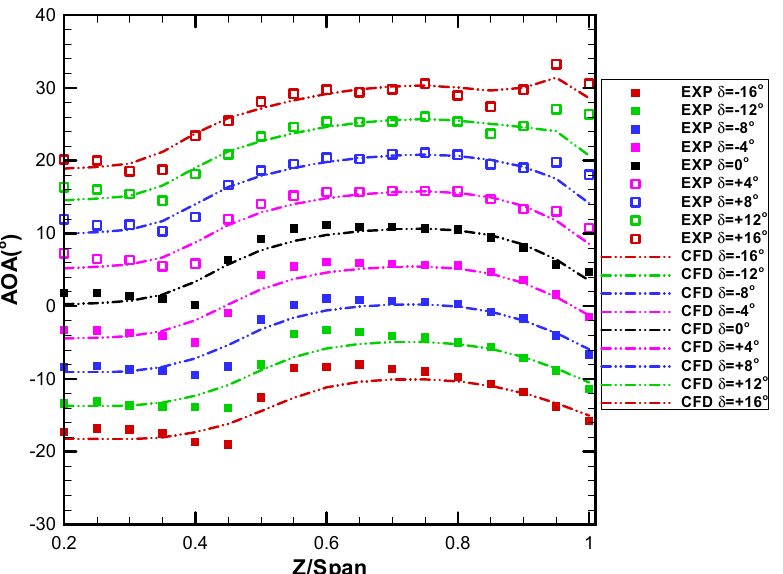
Figure 18. Comparison of angle-of-attack distribution in flat-type rudder inflow (STB side, symbol: experiment, dotted line: numerical simulation).